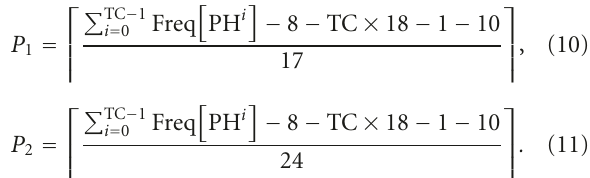
templates to be embedded using 4 × 4 templates, respectively.